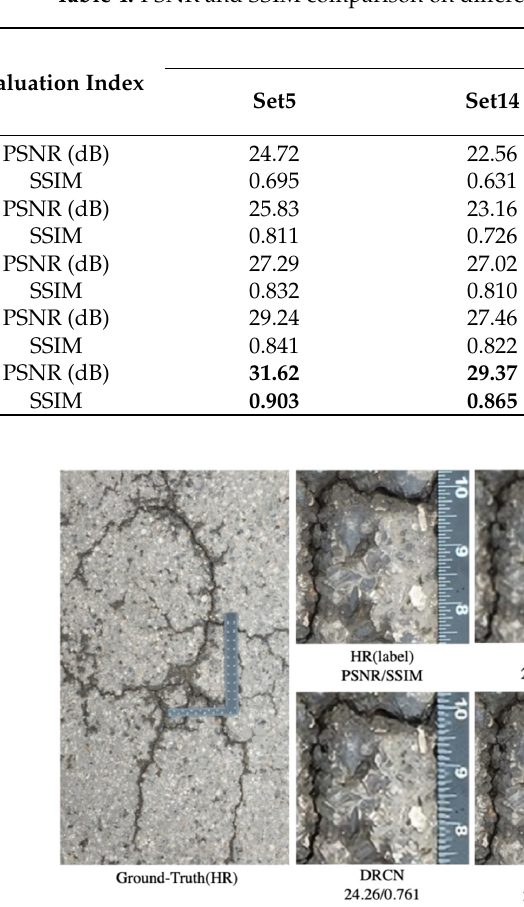
Figure 8. Comparison of network parameters and PSNR. Table 4. PSNR and SSIM comparison on different data sets.